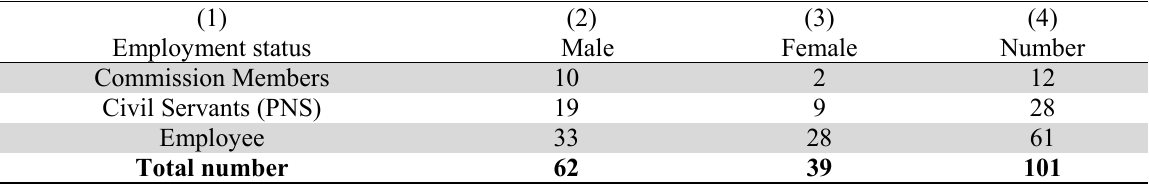
Populations details: Member of the Commission, Civil Servants, and Employees in Environmental KPID Riau Islands